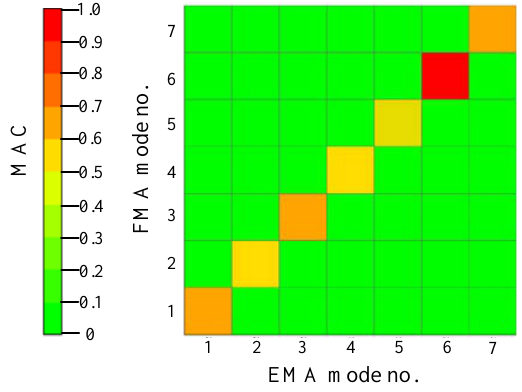
Figure 12. MAC for EMA vs. FMA vibration modes.